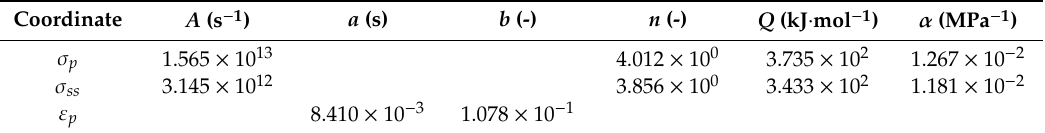
Table 2. Material constants of the Zener–Hollomon based approach.